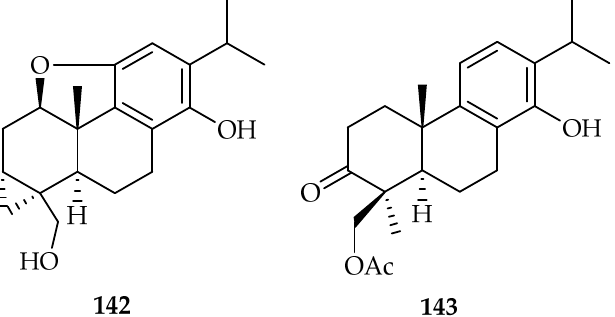
Figure 58. Structures of hypoglicin R 142 [87] and 18-acetyl-triptobenzene A 143 [87]. Chemical investigation of the dichloromethane extract of the aerial parts of Plectranthus scutellarioides (Lamiaceae) led to the isolation and characterization of the abietane diterpene 6-acetylfredericone B 144 (Figure 59). Compound 144 exhibited a cytotoxic effect, with an IC 50 value of 17.6 µ M against MM-CSCs (human multiple myeloma cancer stem) cells, using bortezomib as a positive control [88].